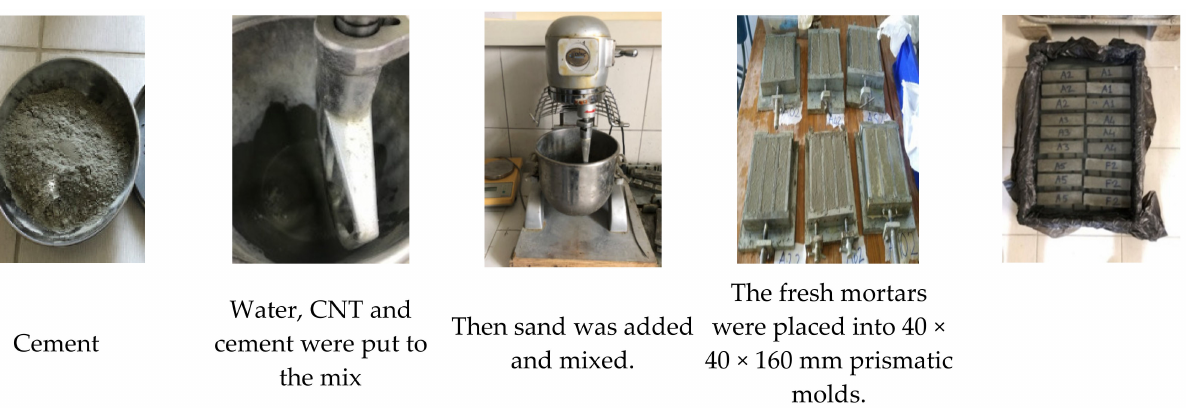
Figure 4. Mortar preparation